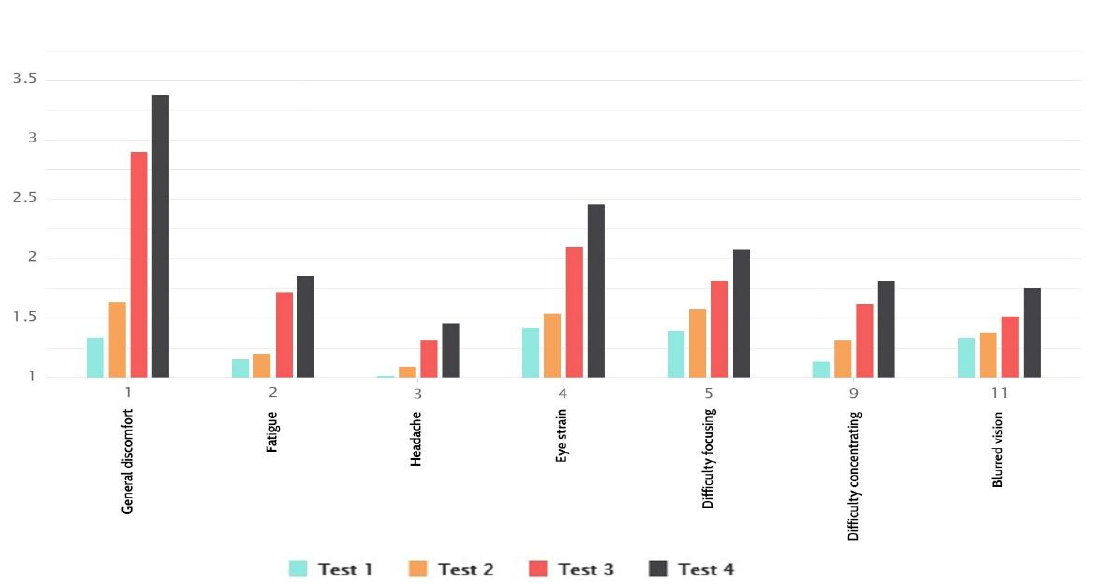
Figure 7. Oculomotor symptoms results.